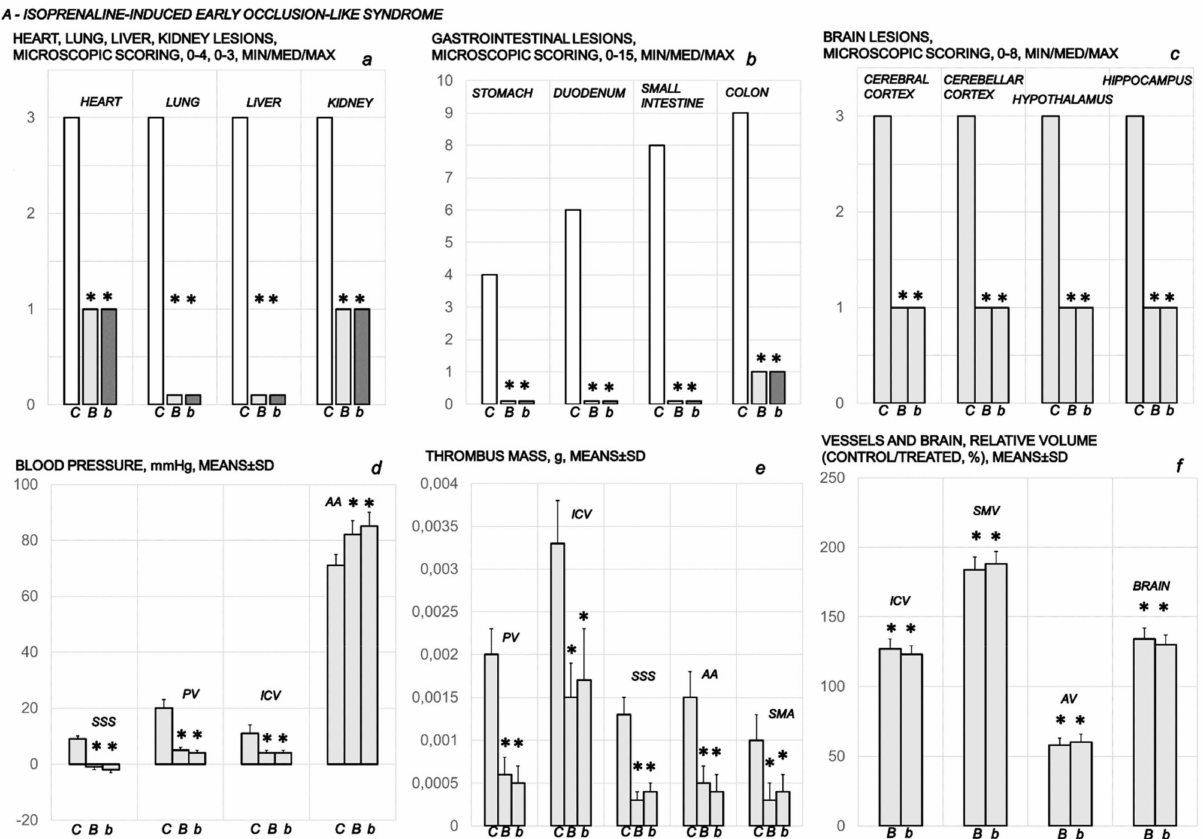
Figure 1. Presentation of the early occlusion-like syndrome in isoprenaline (75 mg/kg sc) treated rats at 30 min after isoprenaline administration. Medication (BPC 157 (10 ng/kg ( b ), 10 µ g/kg ( B ) i.p. or saline 5.0 mL/kg ( C ) i.p.) was given 5 min after isoprenaline. Heart, lung, liver and kidney lesions microscopic scoring ( a ); gastrointestinal lesion microscopic scoring ( b ); brain lesion microscopic scoring ( c ); blood (superior sagittal sinus (SSS), portal vein (PV), inferior caval vein (ICV), abdominal aorta (AA)) pressure ( d ); thrombus mass (portal vein (PV), inferior caval vein (ICV), superior sagittal sinus (SSS), abdominal aorta (AA) and superior mesenteric artery (SMA)) ( e ); and vessels (inferior caval vein (ICV), superior mesenteric vein (SMV), azygos vein (AV) and brain relative volume ( f ) assessments were carried out. Ten rats per each experimental group. Means ± SD, min/med/max, * p < 0.05, at least, vs.